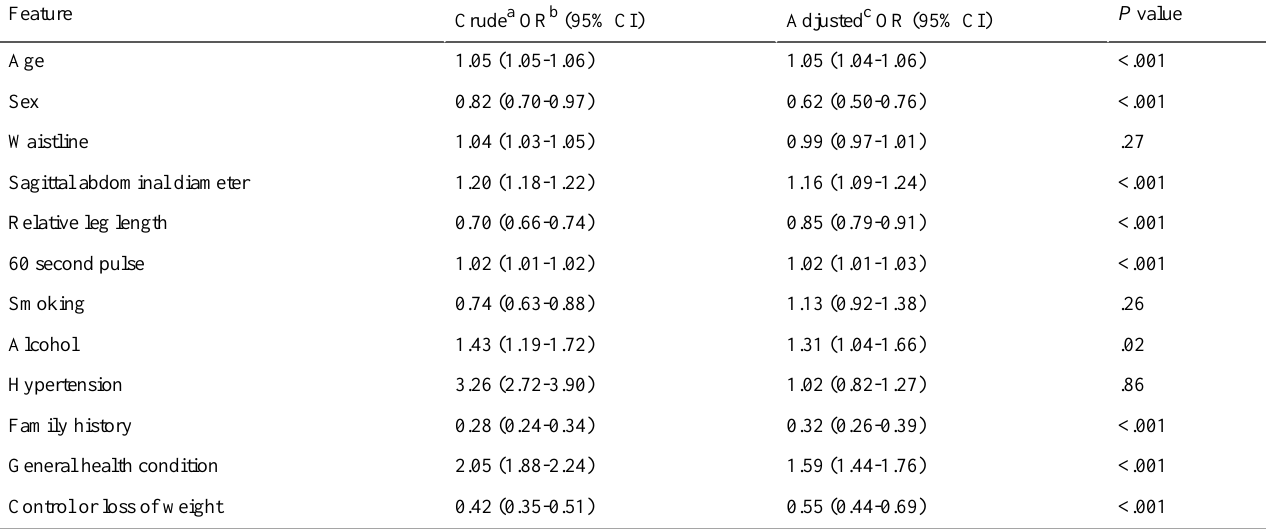
Table 1. Factors associated with diabetes used to build the